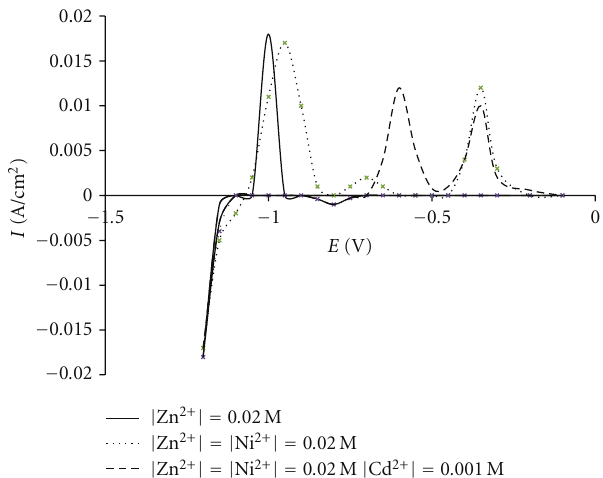
Figure 4: Cyclic voltammograms at a scan rate 5mV/s of a metallic solution containing | Na 2 SO 4 | = 0.5M at pH = 3.5.